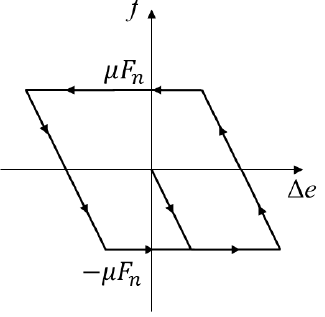
Figure 3. The schematic of the Coulomb friction model.